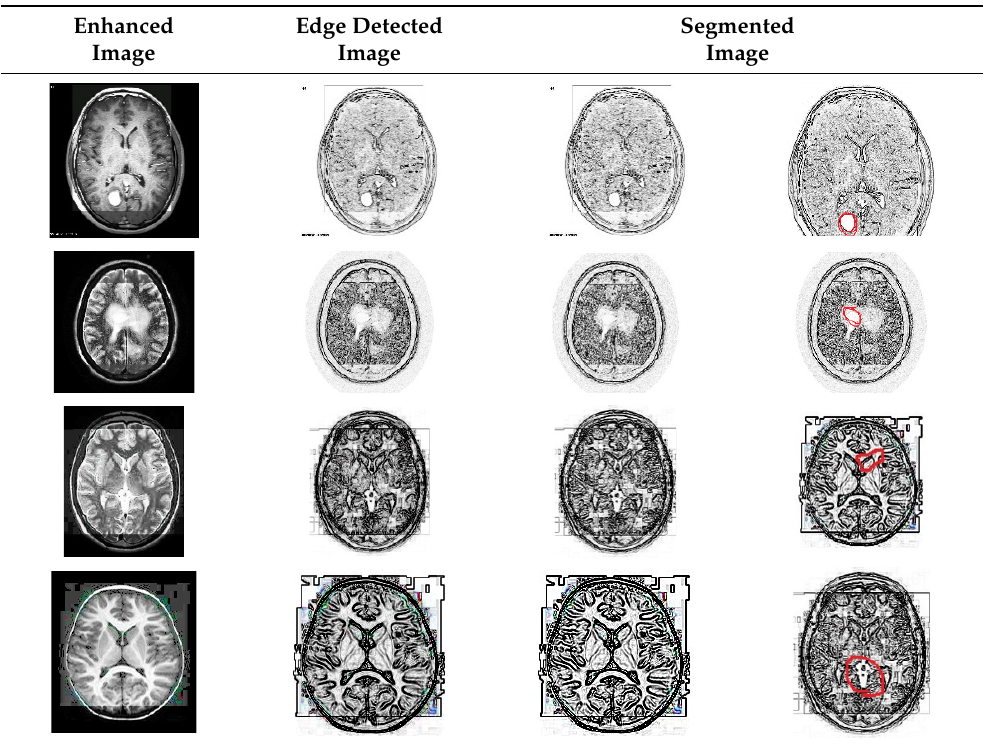
Table 2. Sample brain tumor region segmented images.